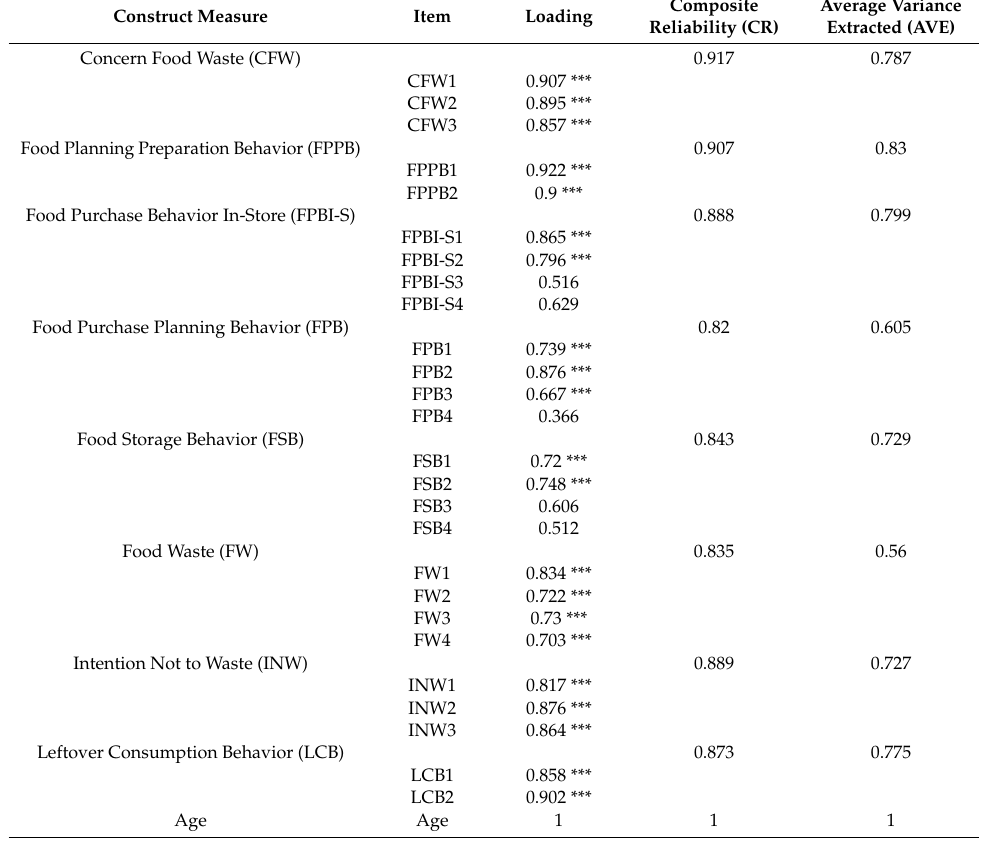
Table 2. Construct measures, items, loadings, reliability, and validity.